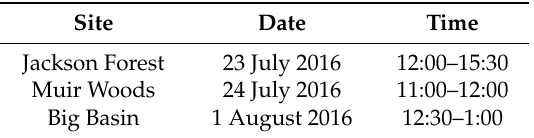
Figure 1. Map of the three study sites and airborne spectroscopy and field data collected. The airborne imaging spectroscopy data are displayed for each site as a three-band RGB (red, green, and blue) composite image. The locations of individual field-collected data (including both training and testing data) are shown as red dots within each site. Field data were collected to cover each Carnegie Airborne Observatory flightline. Table 1. Date and time of Carnegie Airborne Observatory (CAO) airborne data acquisition and date of field data acquisition from each site.